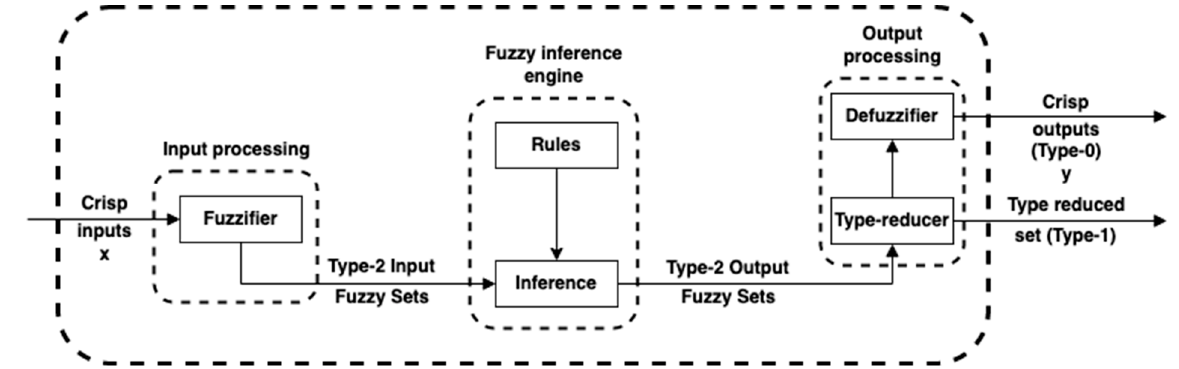
Figure 5. Fuzzy logic system.